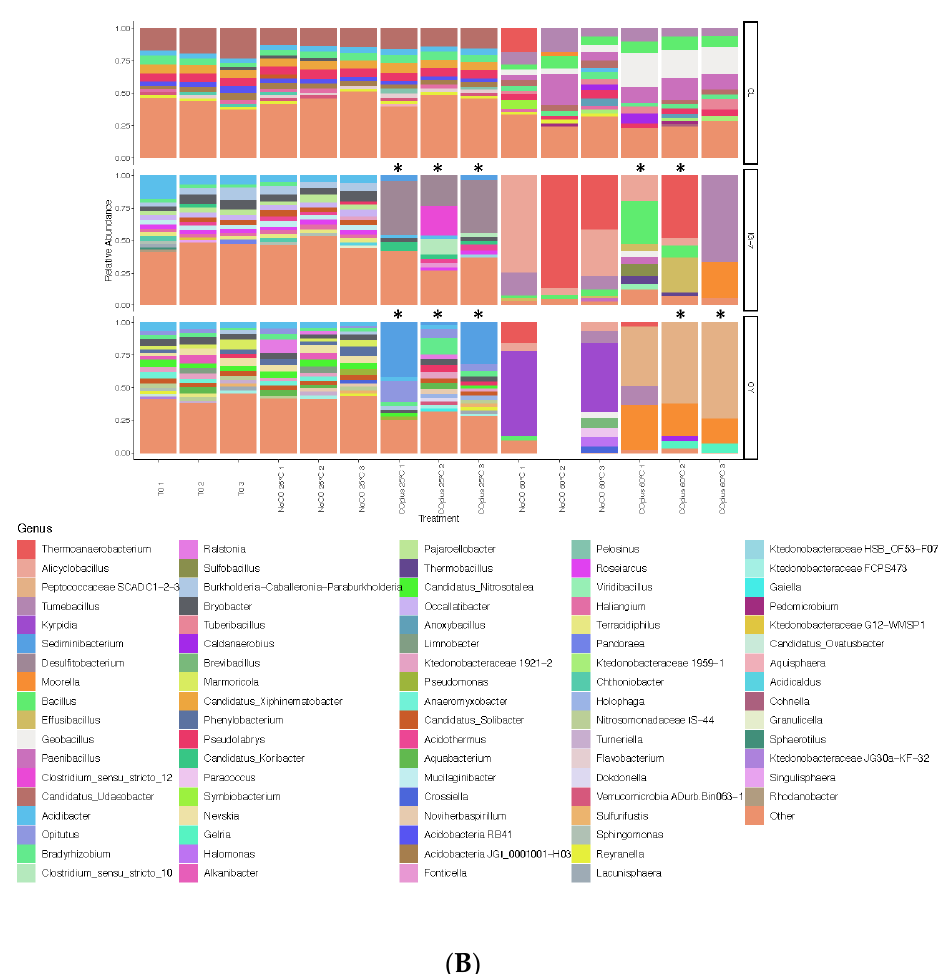
Figure 3. Taxonomic composition for sites CL, IG-7, and OY, at each treatment for T0, No CO 25 ◦ C, 25% CO 25 ◦ C, No CO 60 ◦ C and 25% CO 60 ◦ C. ( A ) Phyla represented are present at relative abundances >1%; ( B ) Genera are present at relative abundances >2%. * Indicates replicates that had no CO uptake activity for Trial